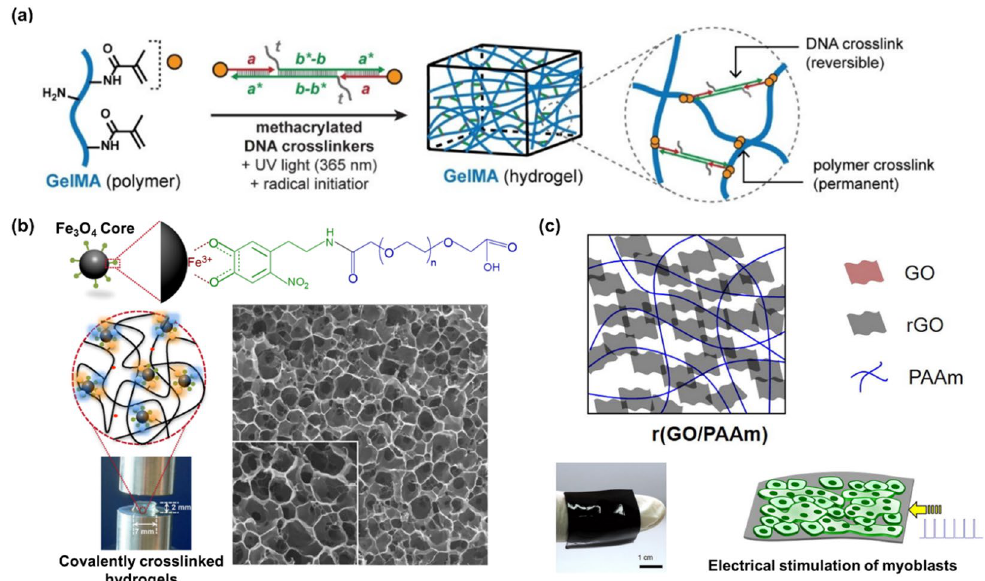
Fig. 3 a Schematic diagram of the control of hydrogel stiffness by manipulating the crosslinking density using DNA crosslinkers. Reproduced with permission from [56], copyright John Wiley and Sons, 2021. b Schematic and optical images of nitro‑dopamine‑modified MNP incorporated into a collagen‑based hydrogel, and SEM image of its internal microstructure. Reproduced with permission from [67], copyright American Chemical Society, 2016. c Schematic and optical images of an rGO‑based hydrogel nanocomposite and its application for the growth and differentiation of myoblasts. Reproduced with permission from [69], copyright Elsevier,